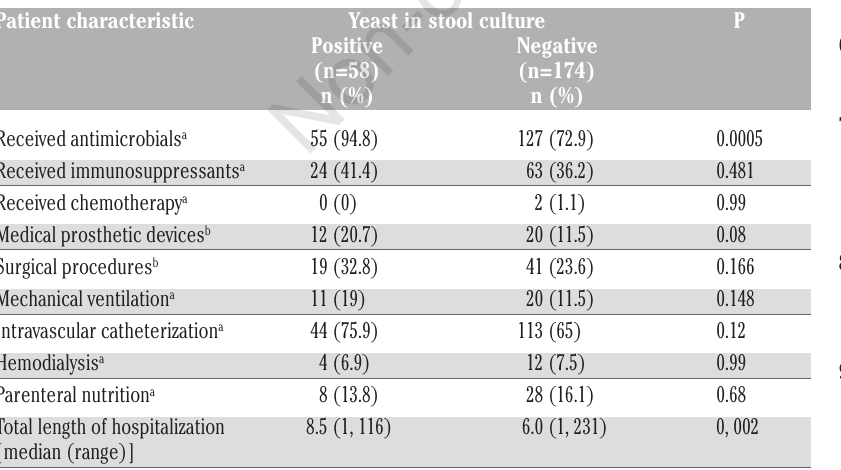
Table 1. Patient characteristics comparing patients with gastrointestinal yeast coloniza- tion to those without colonization. Patient